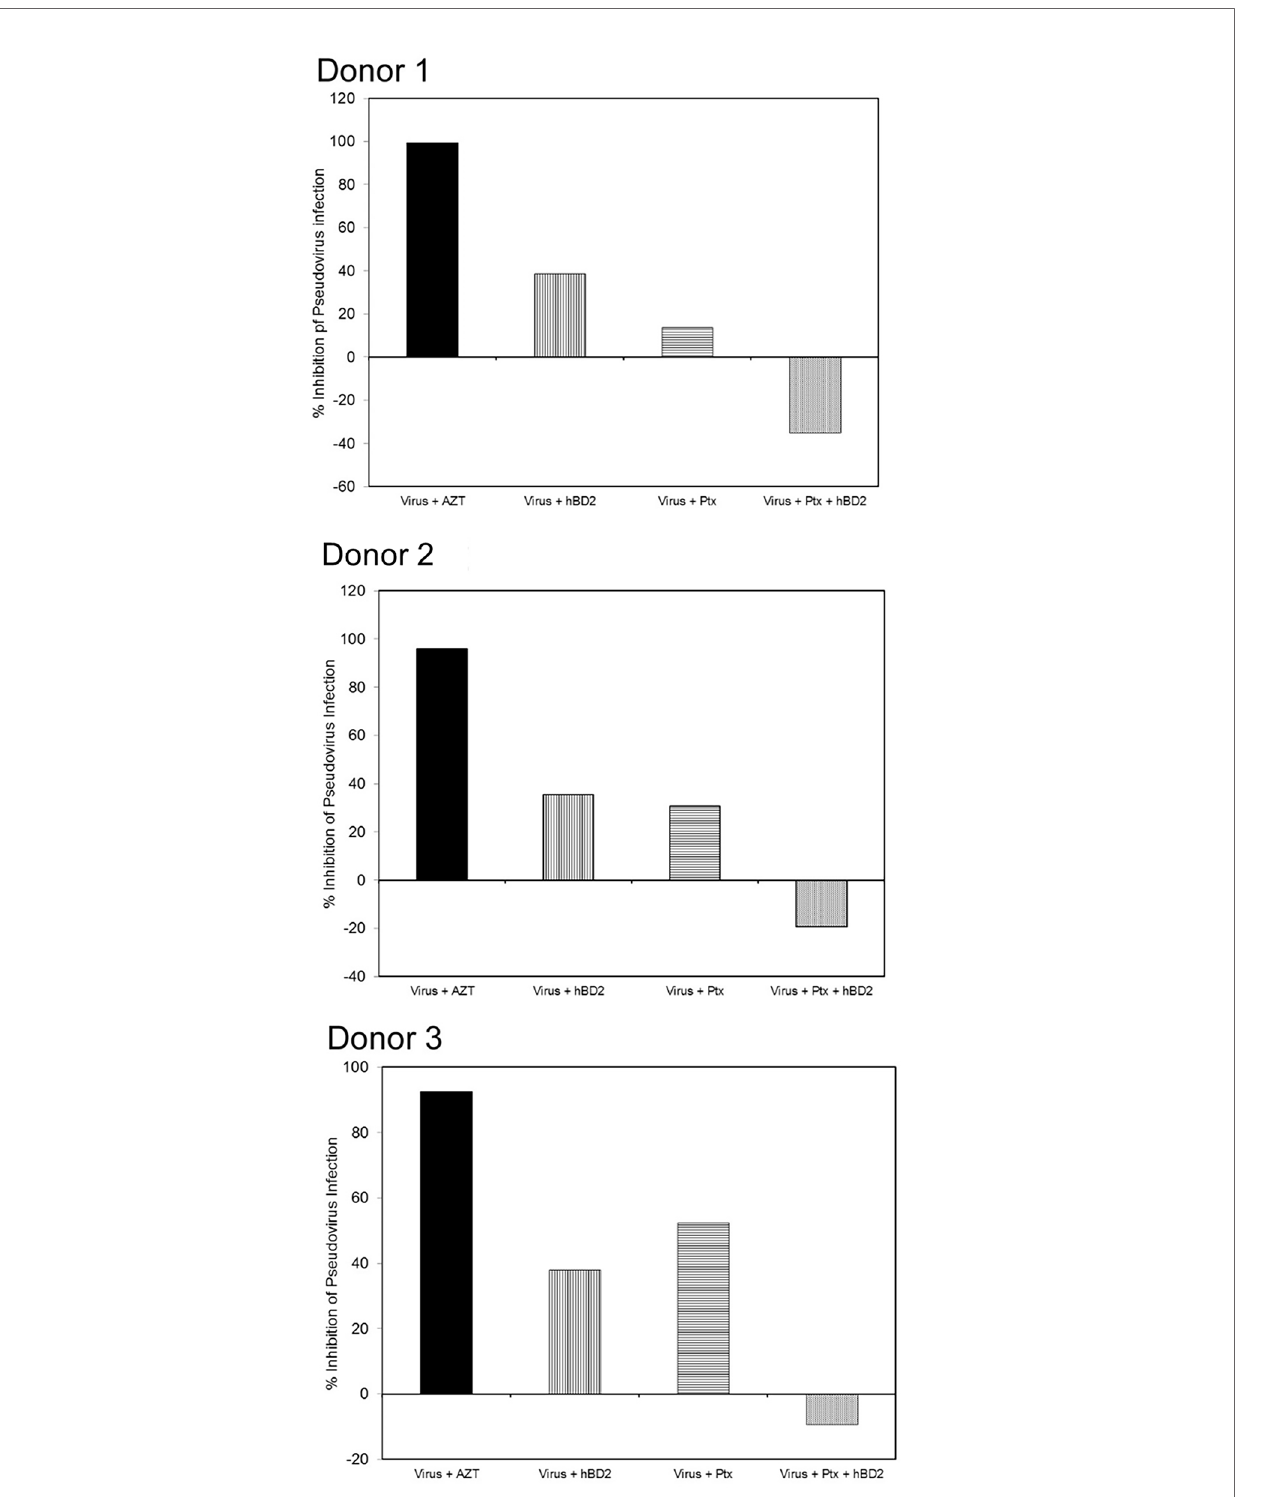
FIGURE 4 | hBD2 inhibits HIV-1 in macrophages post-entry via G i -protein-mediated signaling. MDM were infected with single-cycle HIV-luciferase virus pseudotyped with AMLV envelope followed by pretreatment with or without PTx (100 ng/ml). Cells were then incubated 3 days in presence or absence of hBD2. Subsequently, cells were lysed and luciferase activity was measured. Percentage of inhibition was calculated for treated infected cells in reference to untreated infected cells. Data are presented for independent experiments from 3 different donors.